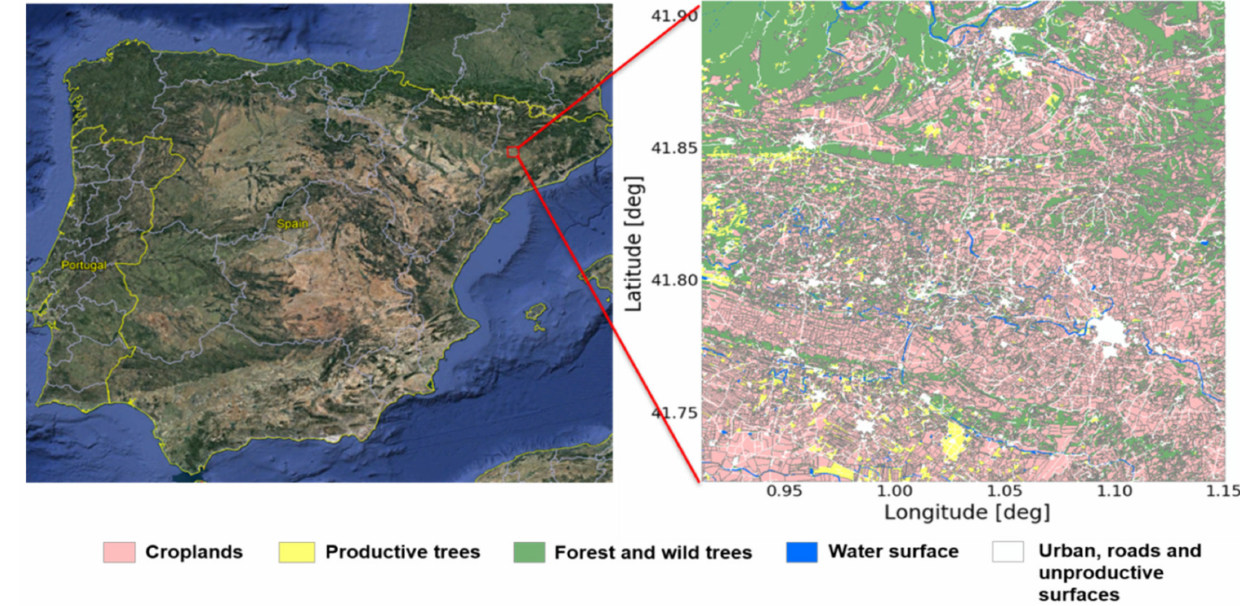
Figure 1. The study area located in Urgell, Catalonia, Spain, and the land use map (source). SIGPAC (Sistema de Informaci ó n Geogr á fica de Parcelas Agr í colas) is a system